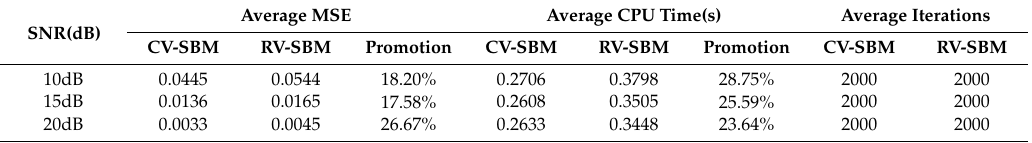
Table 4. Comparison of CV-SBM and RV-SBM when tol = 2e − 4 , k max = 2000 and n =